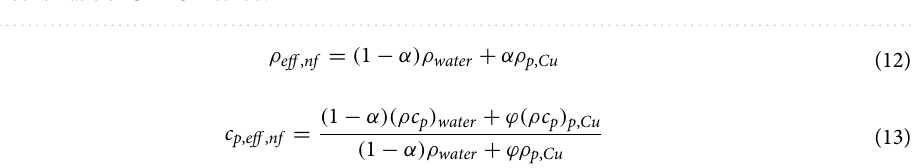
Figure 2. schematic of GAFIS